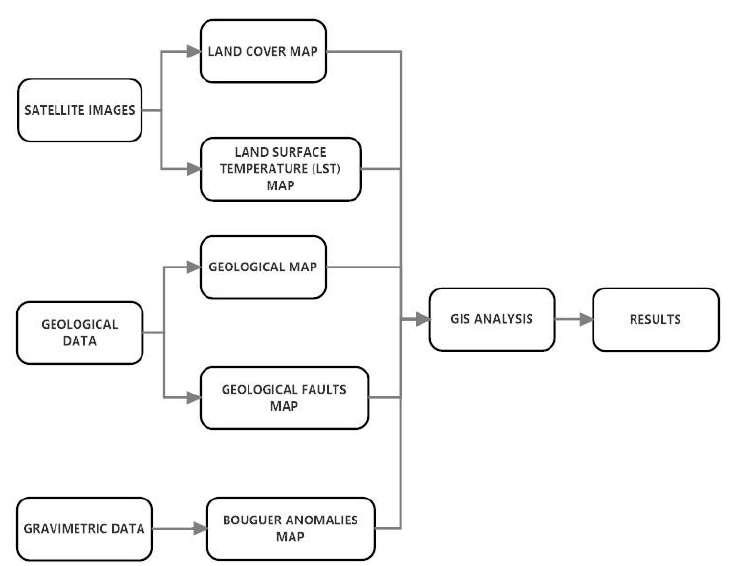
Figure 1. Research workflow.